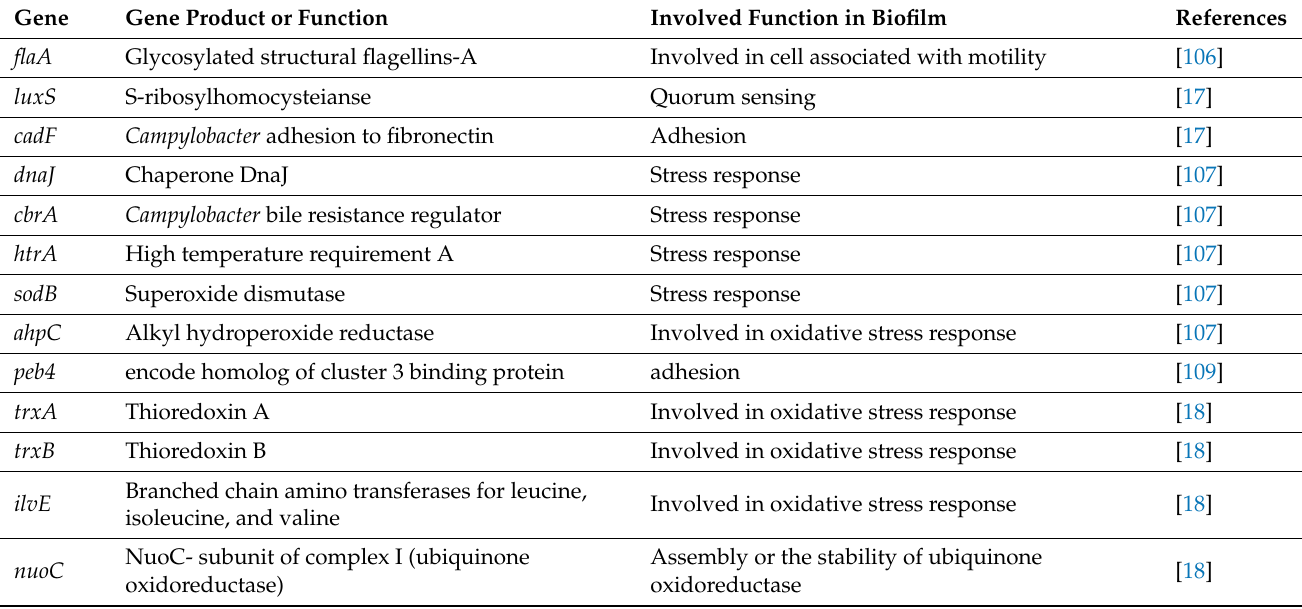
Table 4. Cluster of genes involved and its function in biofilm formation in Campylobacter jejuni .